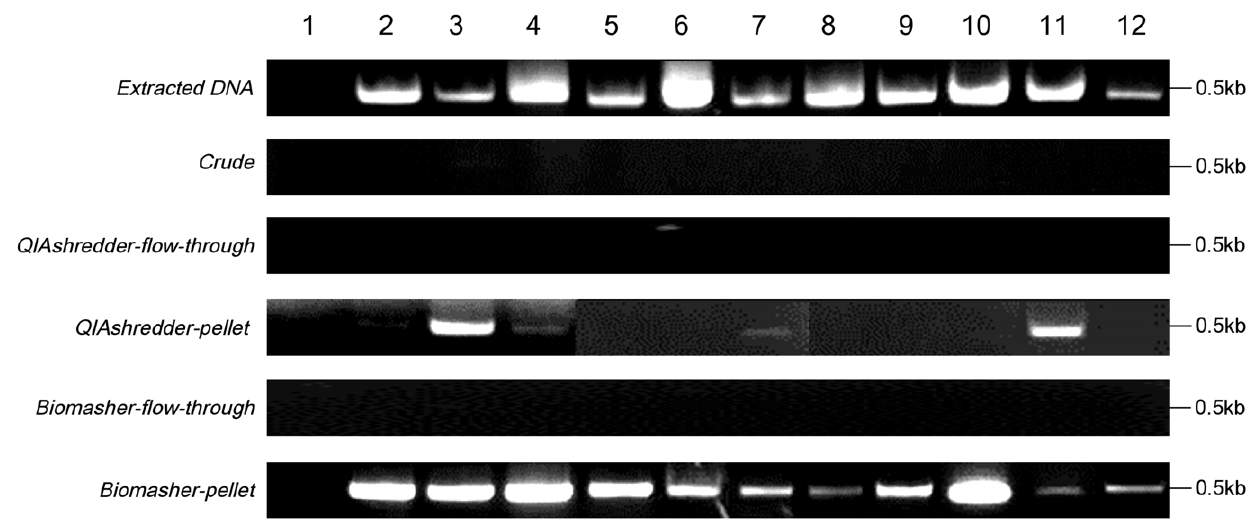
Figure 1. Assays of direct and conventional PCR. Templates obtained using the six preparation methods were used for direct and conventional PCR. Amplicons of each PCR were confirmed using 1.5% agarose gel electrophoresis. Lane 1, Healthy; lane 2, Ishigaki1-A; lane 3, Ishigaki1-B; lane 4, Ishigaki1-C; lane 5, Kin1-A; lane 6, Kin1-B; lane 7, OK901-A; lane 8, OK901-B; lane 9, Ishigaki3-A; lane 10, Ishigaki3-B; lane 11, Ishigaki4-A; and lane 12, Miyako13-A.